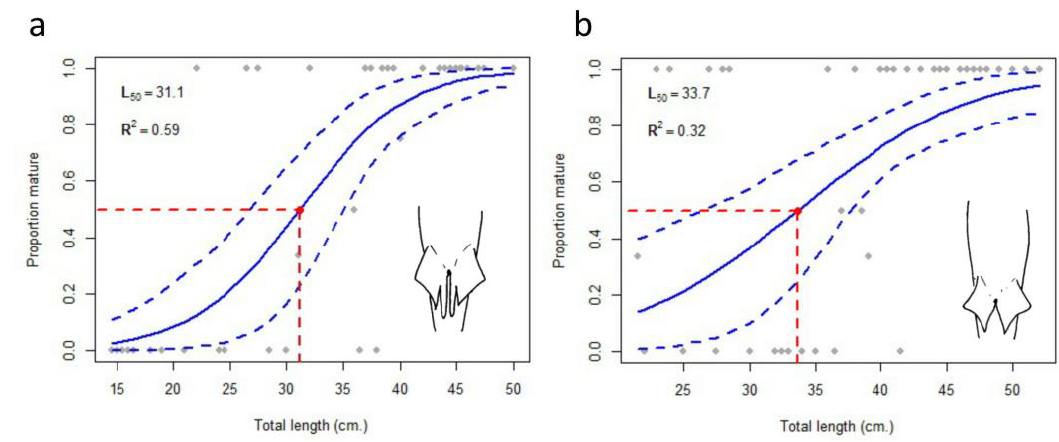
Figure 4. Plotting the maturity ogives of G. melastomus male ( a ) and female ( b ) specimens: values of size at gonad maturity (L 50 ) and R-squared (R 2 ) are reported. Grey dots refer to the specimens analyzed. Red dots indicate the L 50 in the curve. Dashed blue curves indicate confidence intervals.